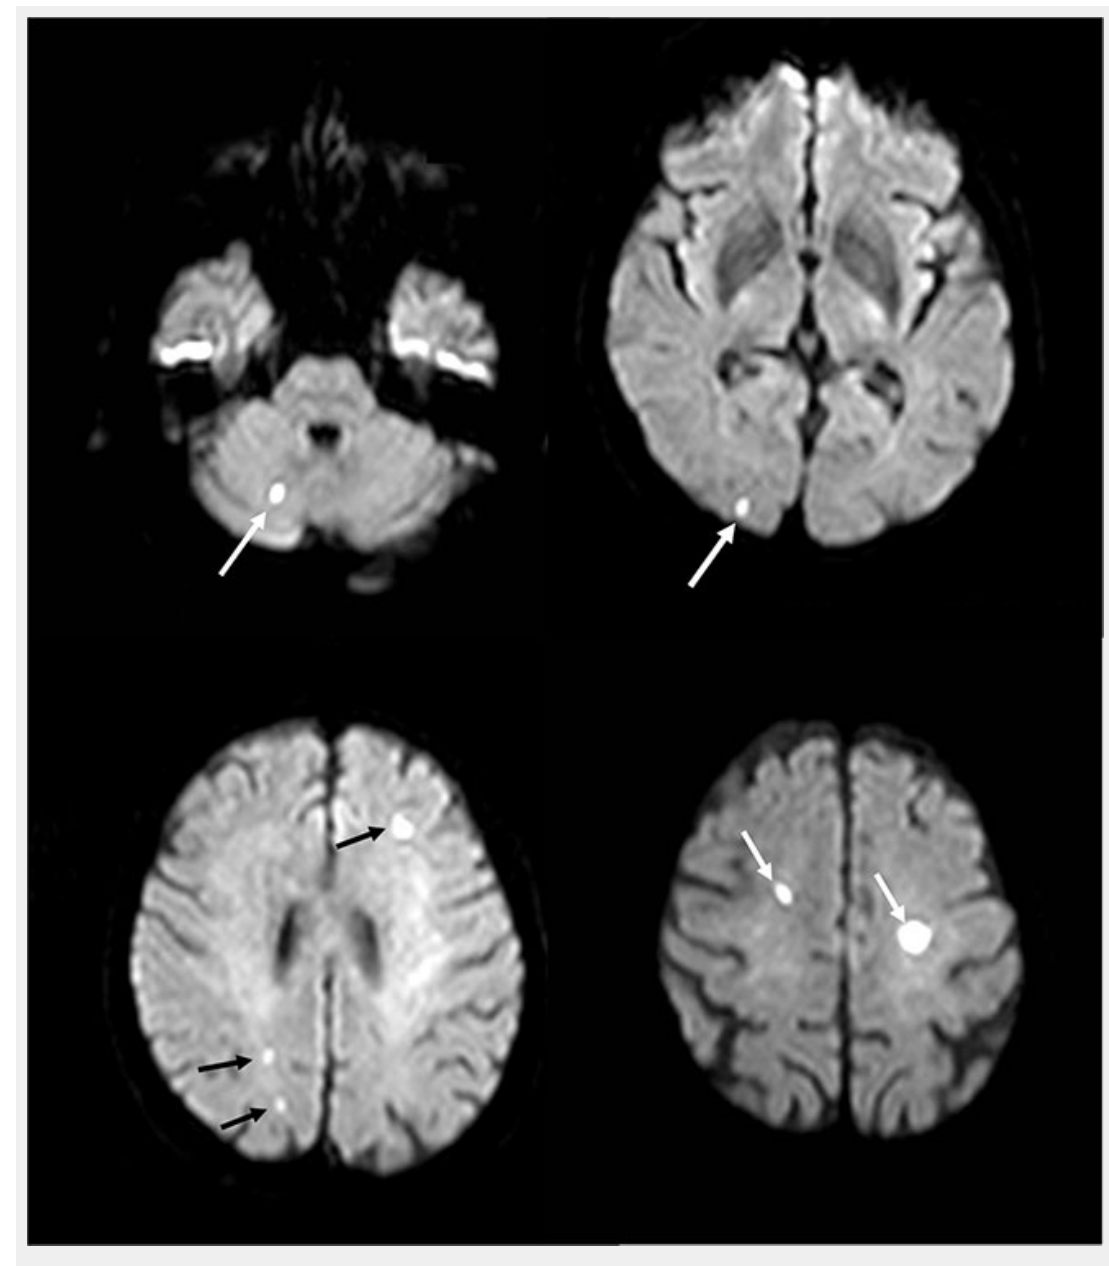
Figure 3 Silent bilateral cerebrovascular emboli after transcatheter aortic valve implantation. Such diffuse, bihemispheric ischaemic lesions can be detected by MRT in 68–77% of patients after